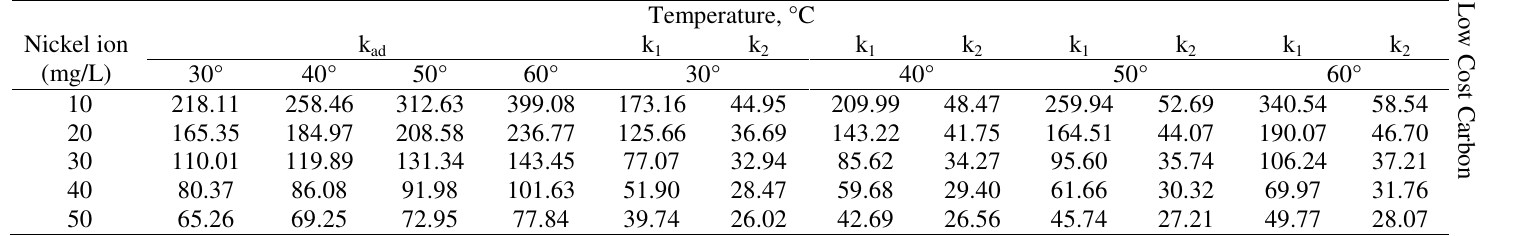
Figure 5 . Intraparticle diffusion effect on the adsorption of nickel ion. Table 7. Rate constants for the adsorption of nickel ions (10 3 k (10 3 K , min -1 ) process 2